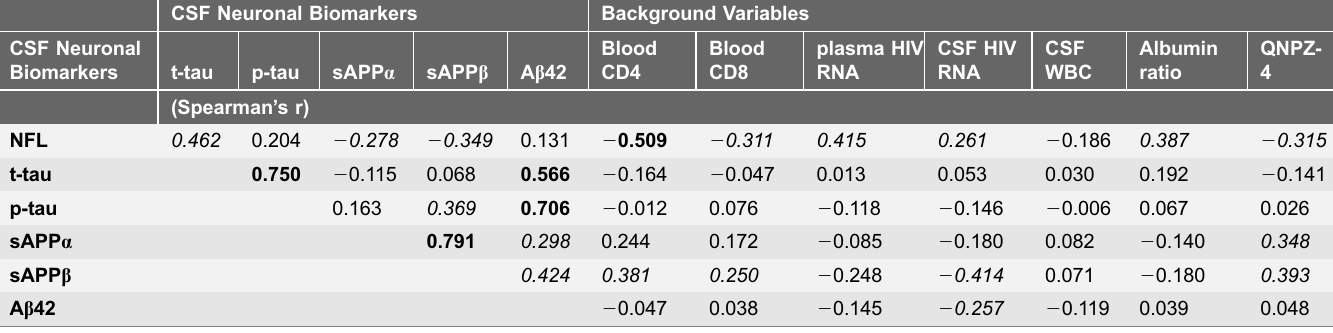
Table 4. Correlations among the CSF neuronal and background biomarkers across the sample of viremic subjects. CSF Neuronal